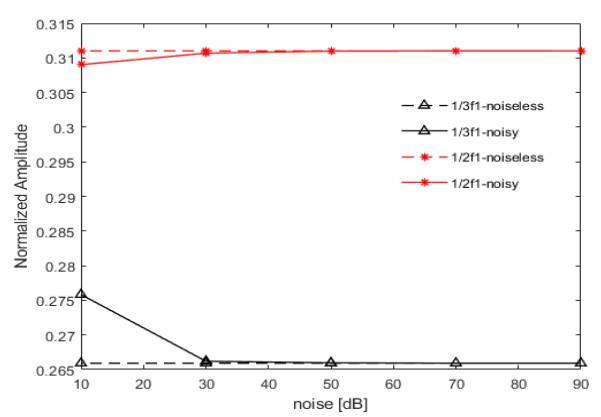
Figure 19. Variation trend of the second harmonic amplitude with noise.